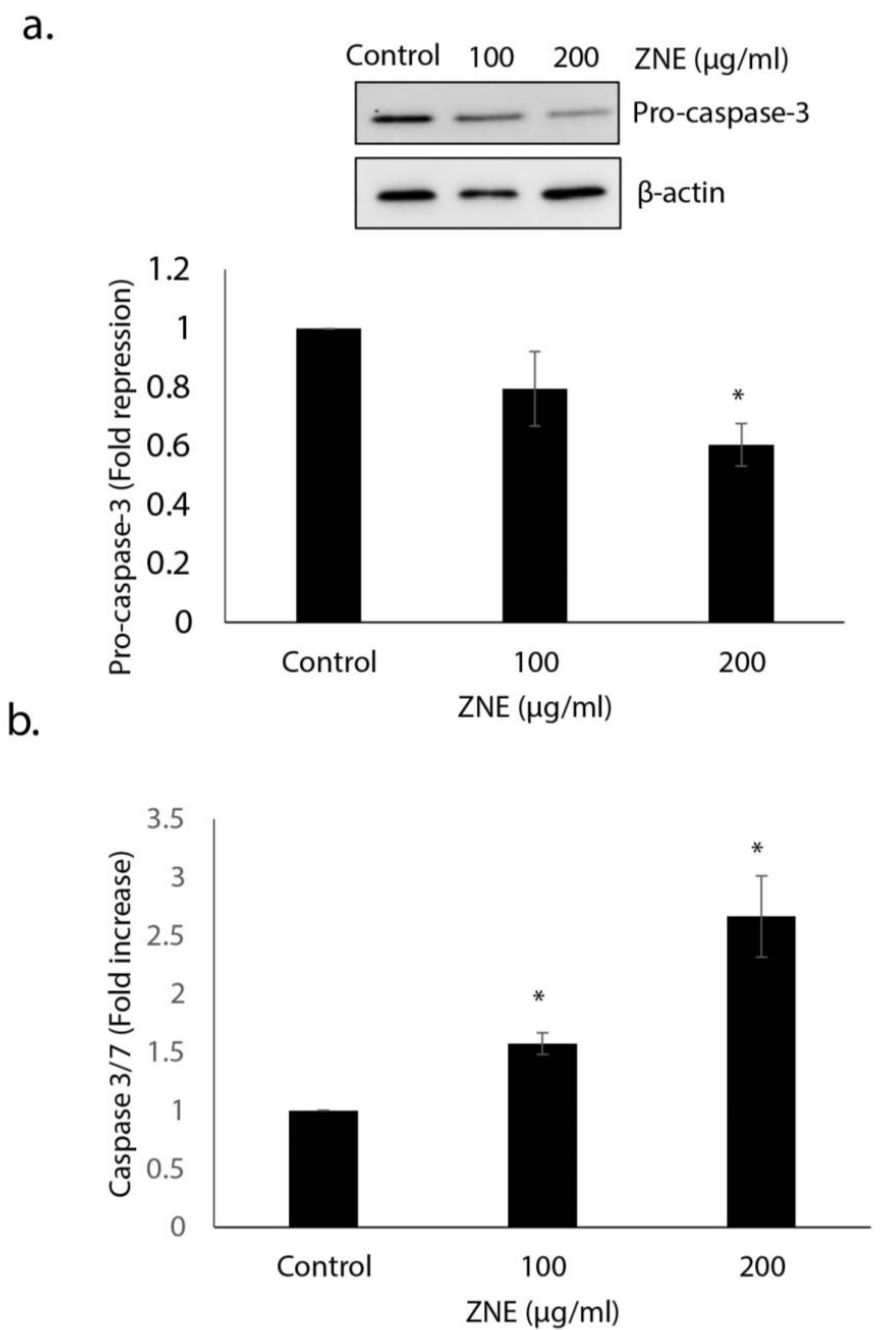
Figure 2. Ziziphus nummularia induces apoptosis in Capan-2 cancer cells . ( a ) Cells were treated for 48 h with or without the indicated concentrations of ZNE. The expression levels of procaspase-3 were determined by Western blotting and β-actin used as loading control. The blot shown is representative of three independent experiments. ( b ) Caspase 3/7 activity was assessed 48 h after treatment of Capan-2 cells with ZNE (100 and 200 μg/mL) or ethanol (control) cells. The relative caspase 3/7 activity was normalized to the number of viable cells per well and is expressed as fold of induction compared to the untreated control cells. * denotes p < 0.05.